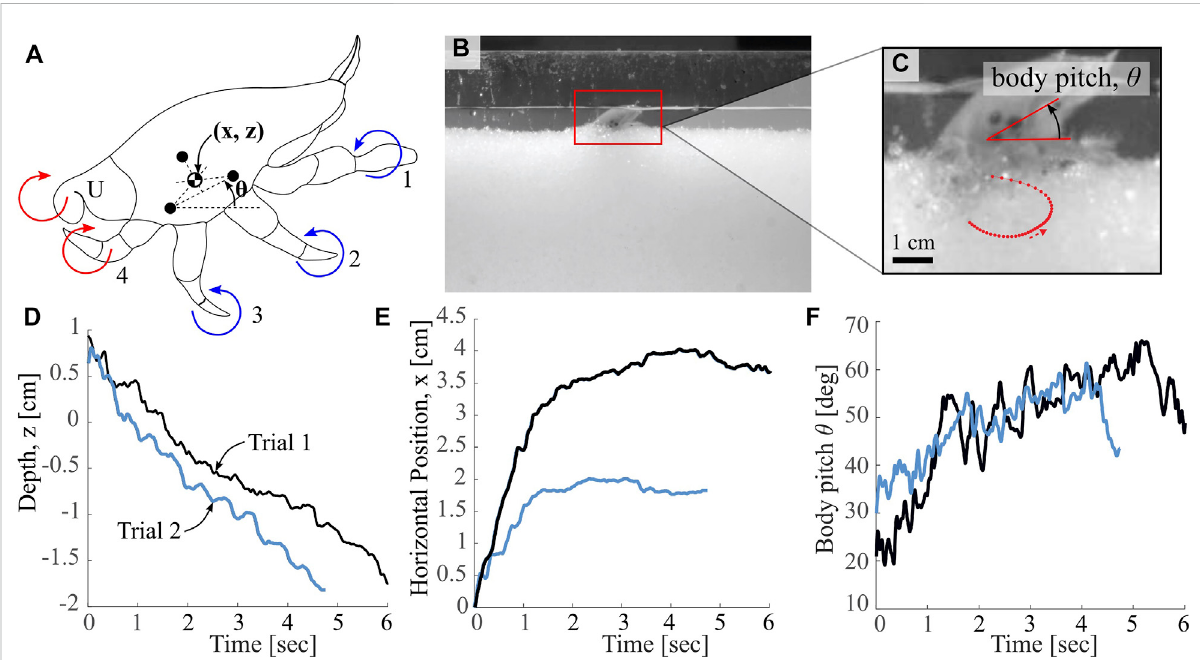
FIGURE 2 Overview of Biological Observations. (A) Labeled depiction of markings used for pose estimation,as well as mole crabappendages (labeled1-4 andU,Uropods),withdirectionofpowerstrokeindicated.Colors(redandblue)indicategroupingsofappendagesproposedinthiswork (B) Imageof “ ant farm ” test bed used for animal experiments, as in McInroe et al. (2020) (C) Image of tracking points on animal, used to calculate leg dynamics, body pitch and orientation data. Red dotted curve indicates a sample leg tip trajectory from this specimen (D,E) Horizontal and vertical translationsthroughoutaburrowing eventfor twodifferenttrialswith asinglecrabspecimen (F) Bodypitchinthesagittalplanerelativetohorizontal throughout a burrowing event for the same two trials in (D) and (E)